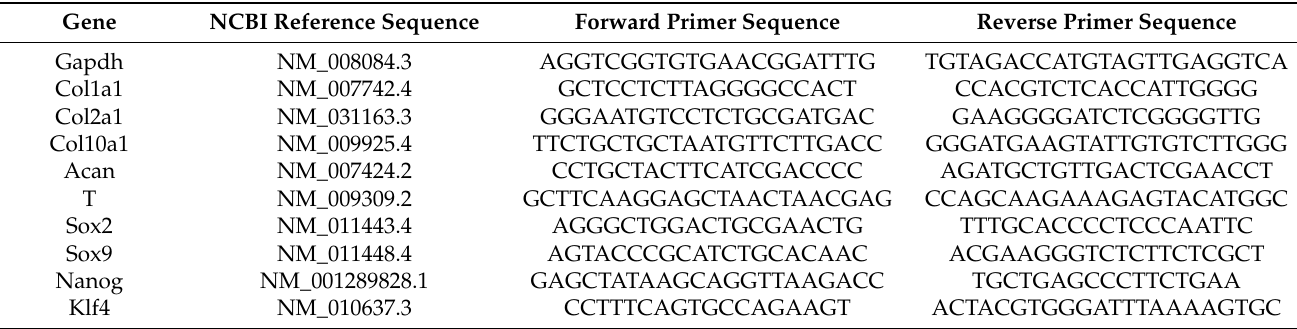
Table 1. Primer sets for real-time PCR analysis.